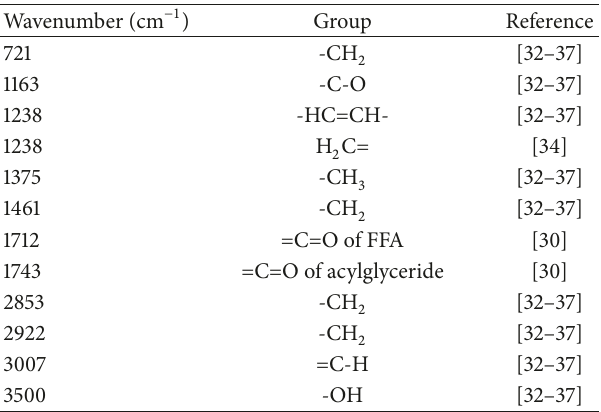
Figure 4: Evolution of OCP measurements during the biodiesel oxidation at different temperatures. Table 2: Main groups identified in the FTIR